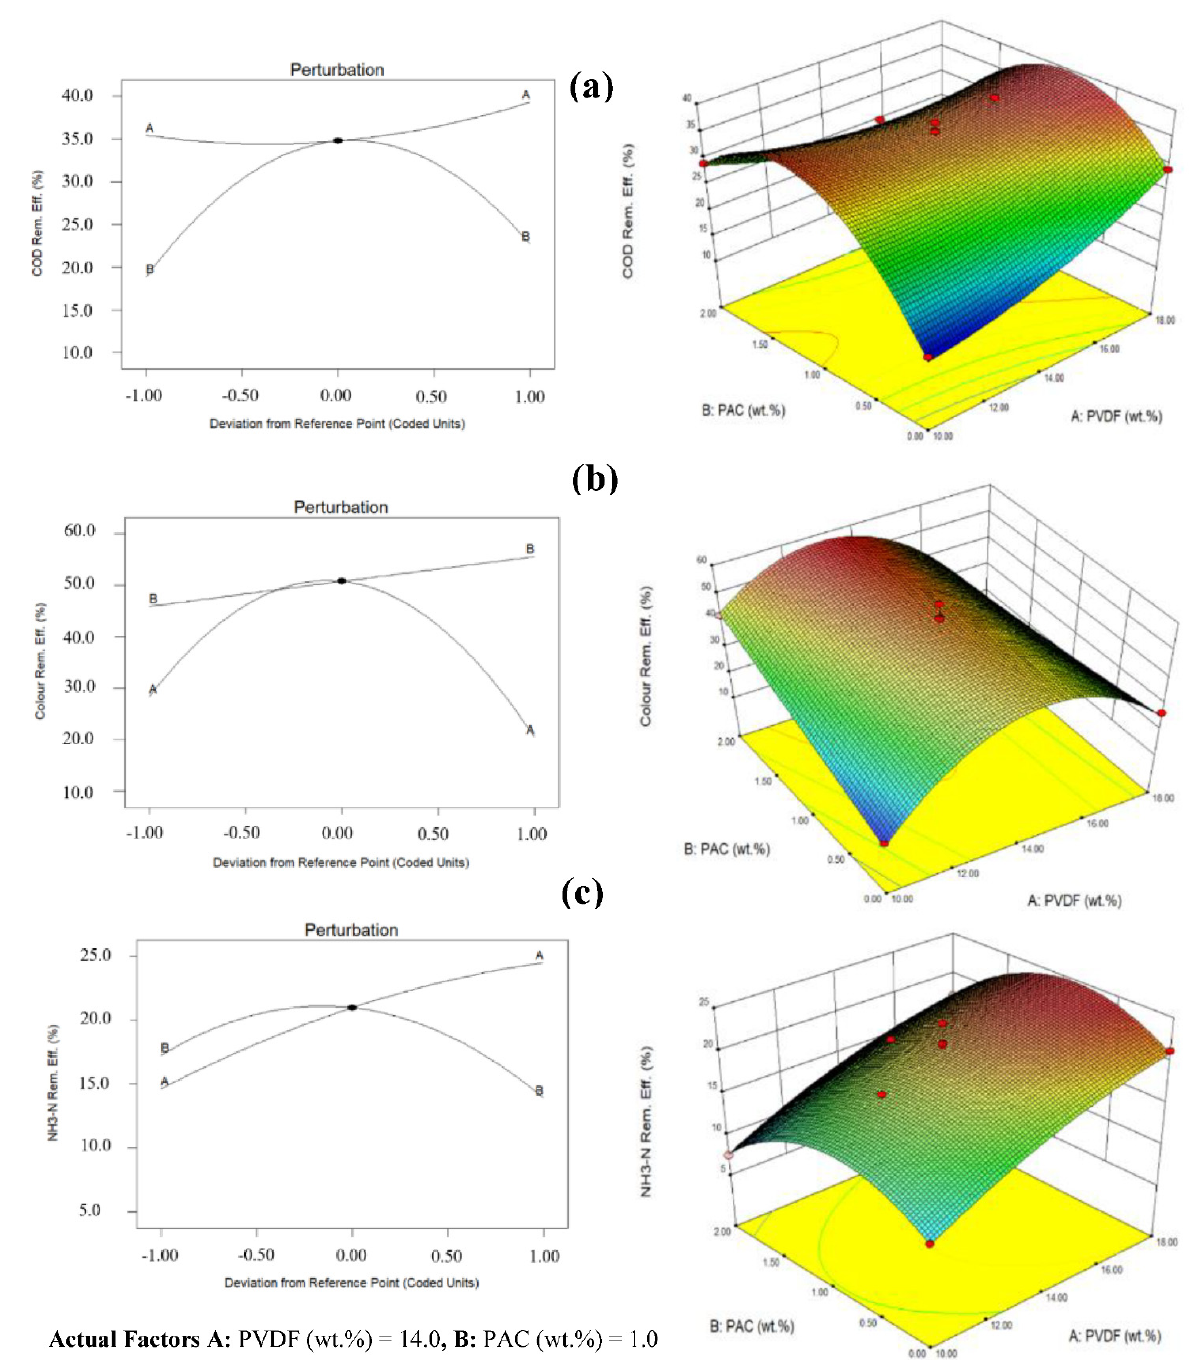
Figure 6. Perturbation plots ( left ) and 3D response surface ( right ) of PVDF-PAC fabricated membrane for the removing efficiency of ( a ) COD, ( b ) colour, and ( c ) NH 3 -N.